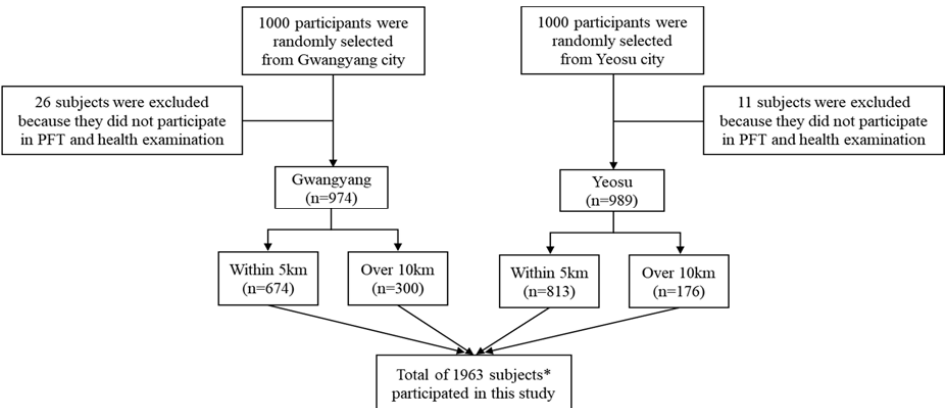
Figure 1. A diagram of selecting the study subjects ( n = 1963) living in Gwangyang and Yeosu